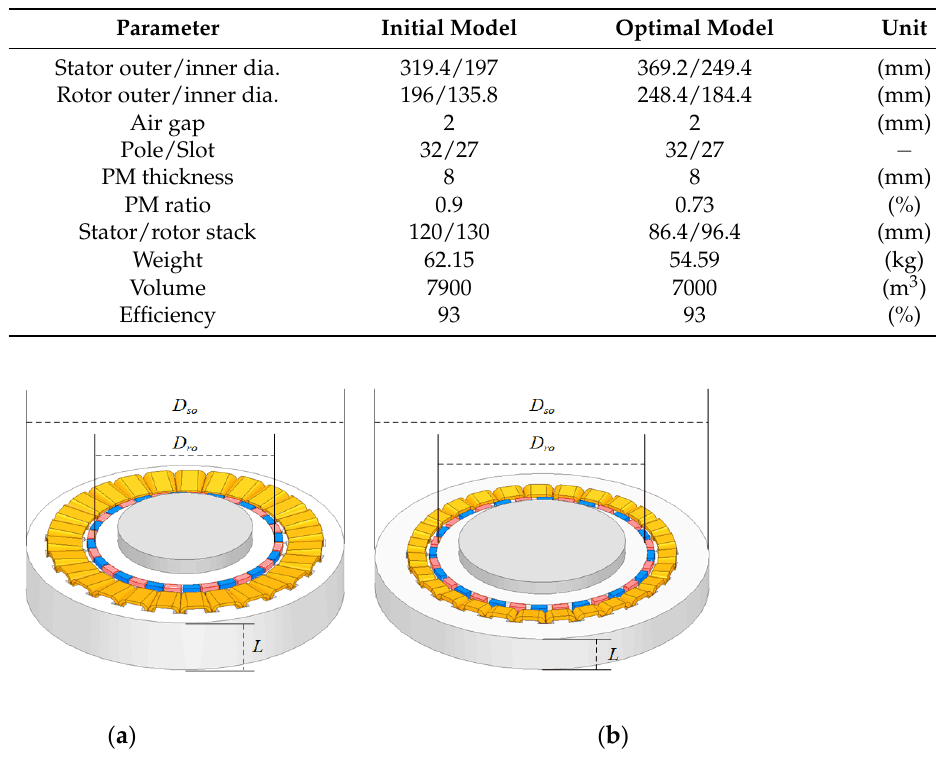
Table 3. Comparison of design specifications of the initial model and the optimized model.